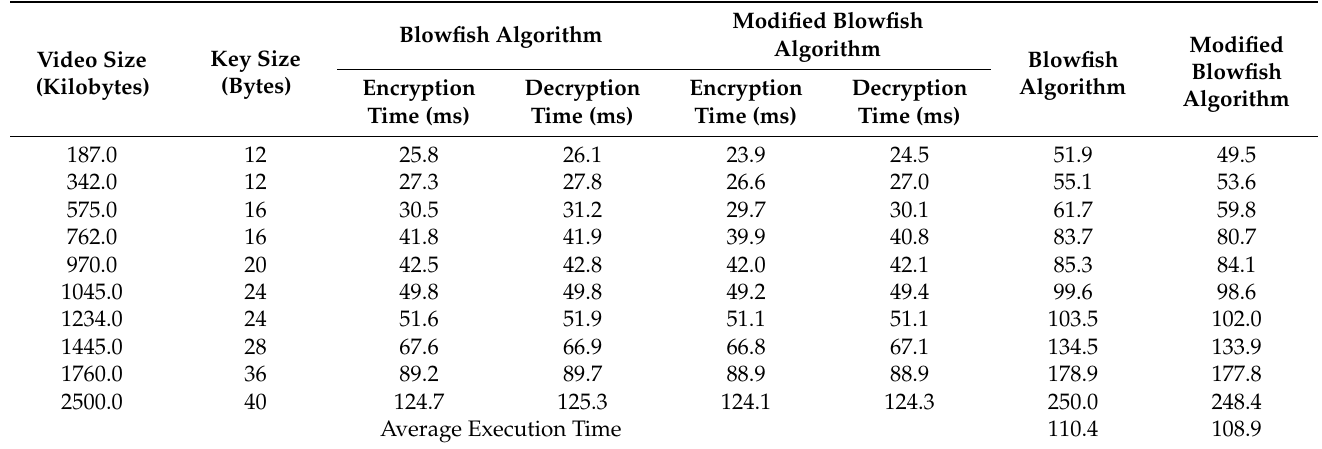
Table 2. Analysis of computational time of Blowfish and modified Blowfish algorithms.